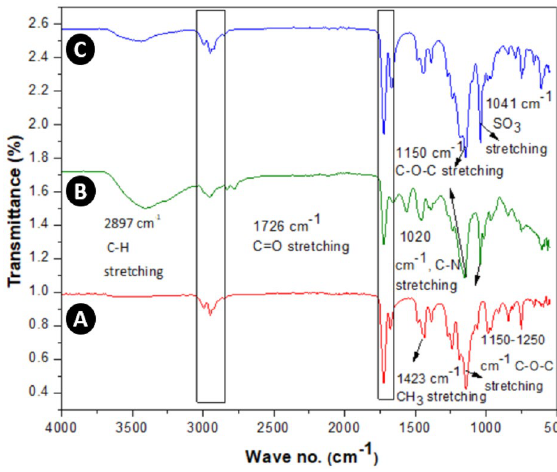
Figure 2. FTIR spectra of polymers p MMA, p MD1 and p